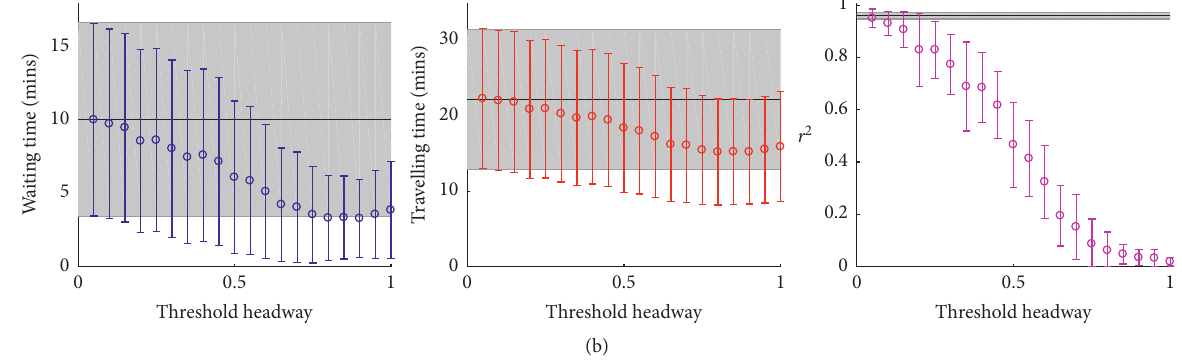
Figure 9: Results of the time-based no-boarding strategy on the two same-velocity scenarios. Each colored point represents the mean and standard deviation of the measured quantities calculated from 100 realizations of each parameter value. The black line and grey shaded area of each graph denote the mean and standard deviation of the measured quantities from a control case, which are simulation runs of the same parameter values, without any intervention strategies. Table 4: Effects of the intervention strategies on the same-velocity scenarios. Each strategy is represented by its best-performing parameter (based on travelling time), with the average waiting time, travelling time (both units of minutes), and degree of complete bunching r 2 presented. The values in parentheses are the standard deviation of each measurement. A null entry represents the control case outperforming the strategy at all parameter values. Lull-same Busy-same Strategy Parameter Wait Travel r 2 Parameter Wait No interventions S-hold (parameter α ) — — — — C-hold (parameter α ) 2.0 0.0 (0.2) 14 (7) 0.0 (0.5) , in units of L / N ) 0.80 8 (5) 20 (9) 0.1 (0.4) 15 (7) 0.1 (0.4) No-boarding (dist, parameter h † d,c No-boarding (time, parameter h † t,c , in units of H t / N ) 0.78 Pulsing (parameter Δ t p )